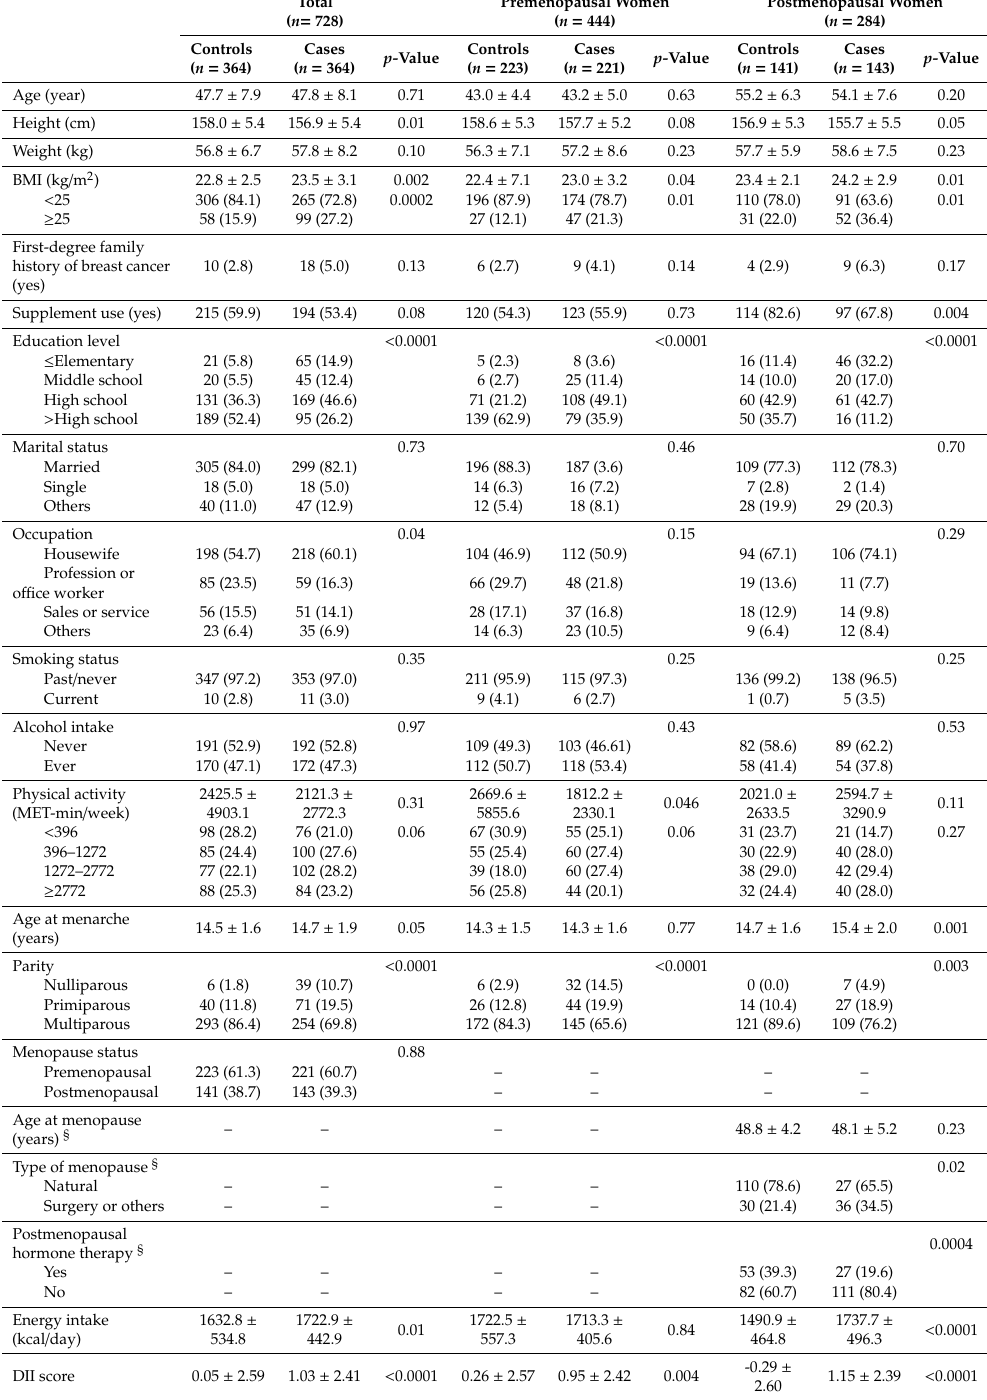
Table 1. General characteristics of the study